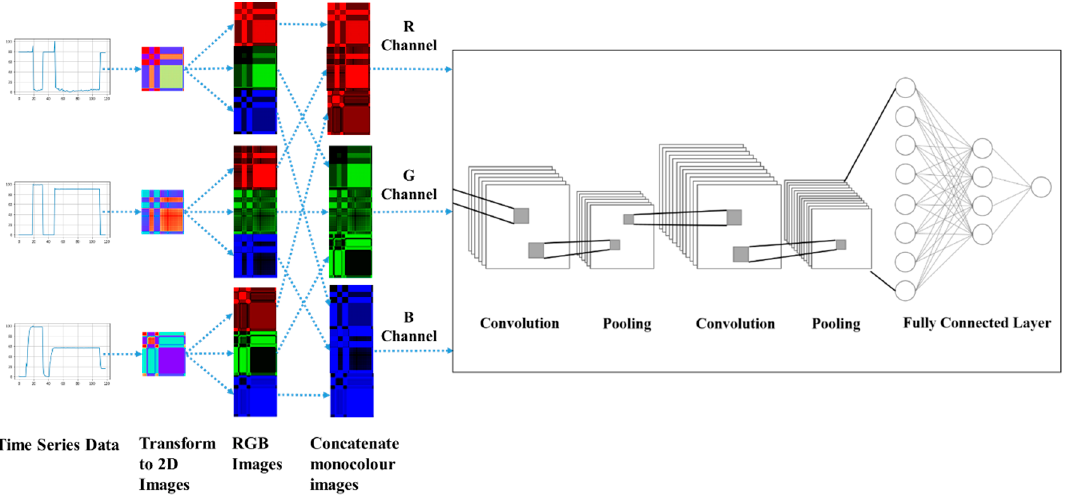
Figure 4. Illustration of the concept of the concatenating method with red, green, and blue (RGB) images, if three time series are considered.